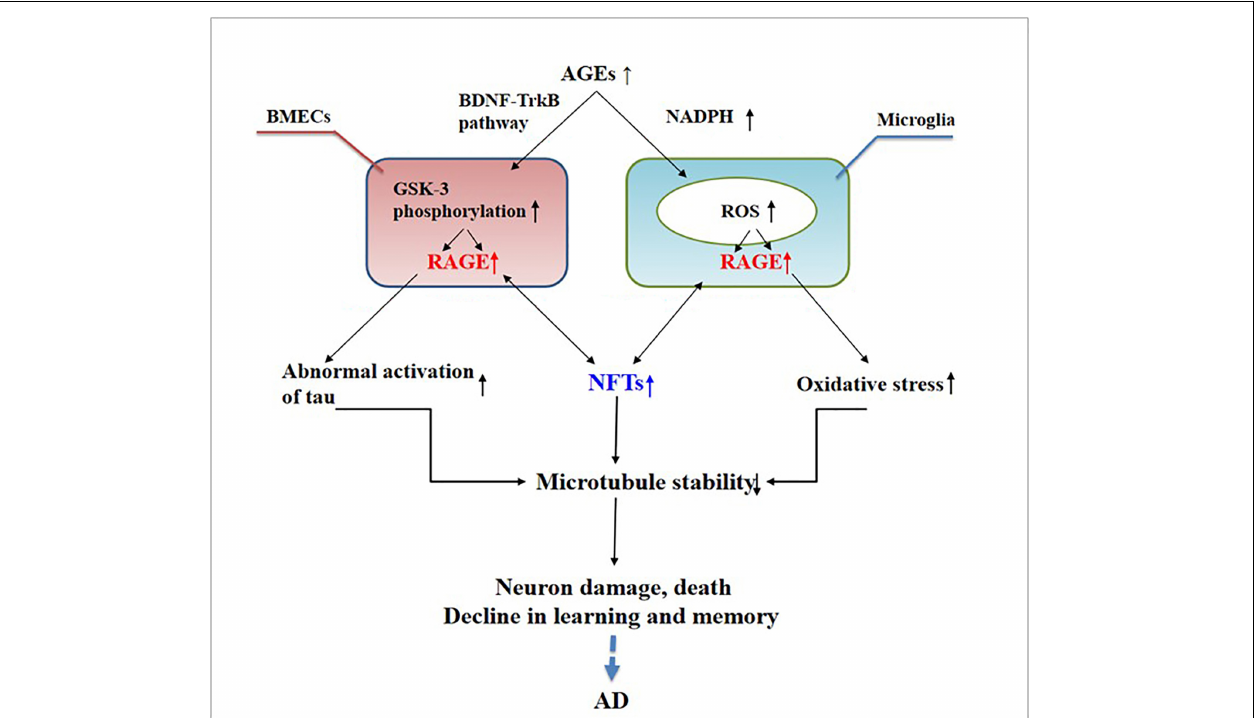
FIGURE 2 | Receptor of advanced glycation end products (RAGE) mediates the possible mechanism of neurofibrillary tangle (NFT) formation in the pathogenesis of dementia complicated with Alzheimer’s